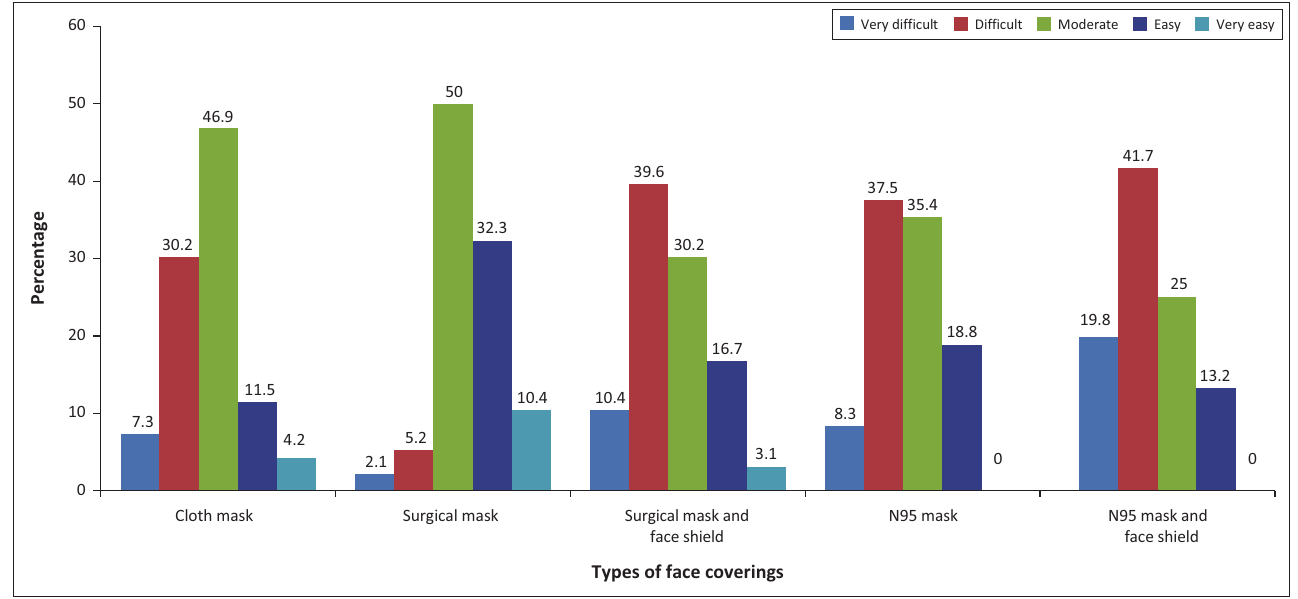
FIGURE 3: Difficulties in listening to a person wearing different types of face coverings ( n = 96).